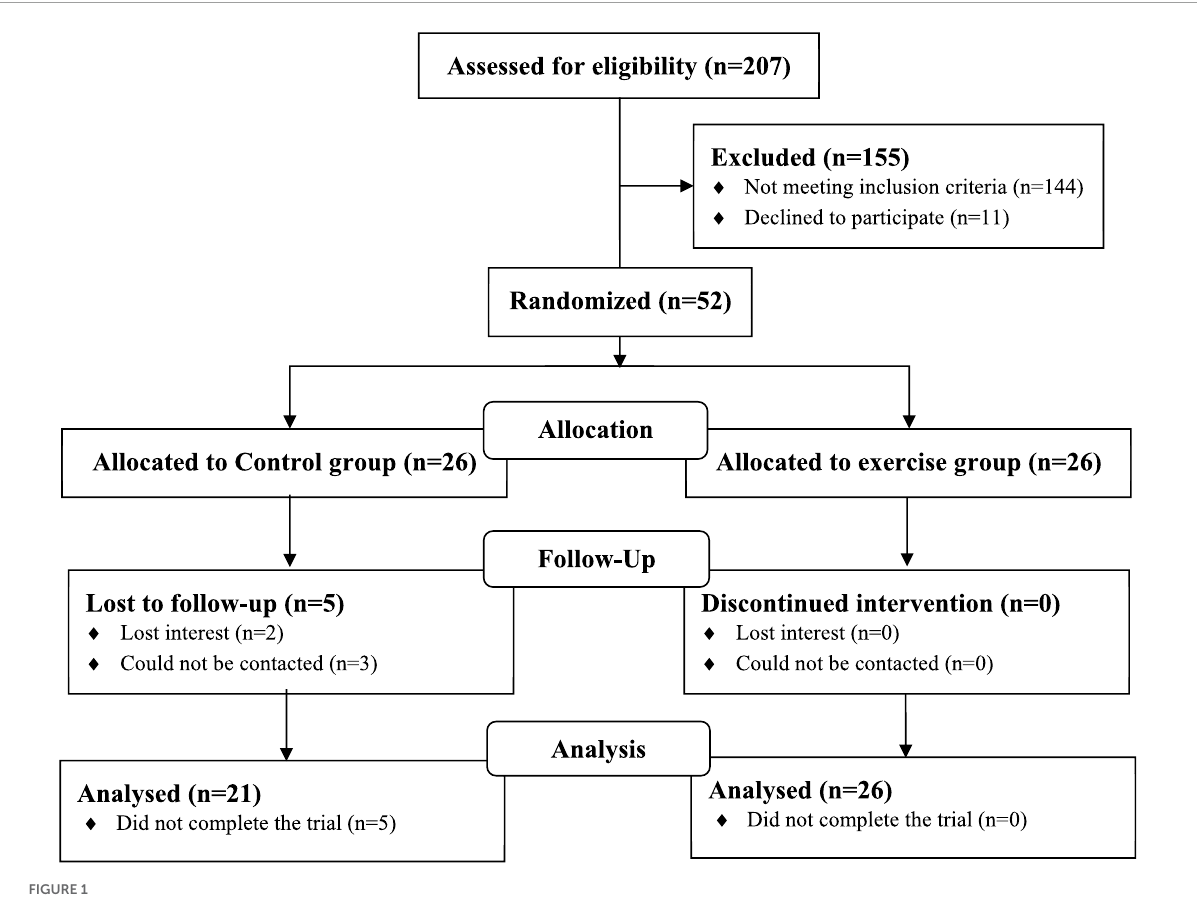
FIGURE1 Participant flow